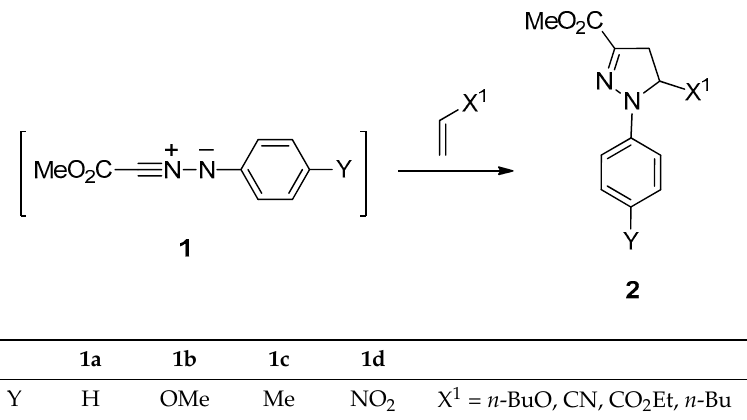
1 -ethenes (reaction group (RG)-I) giving